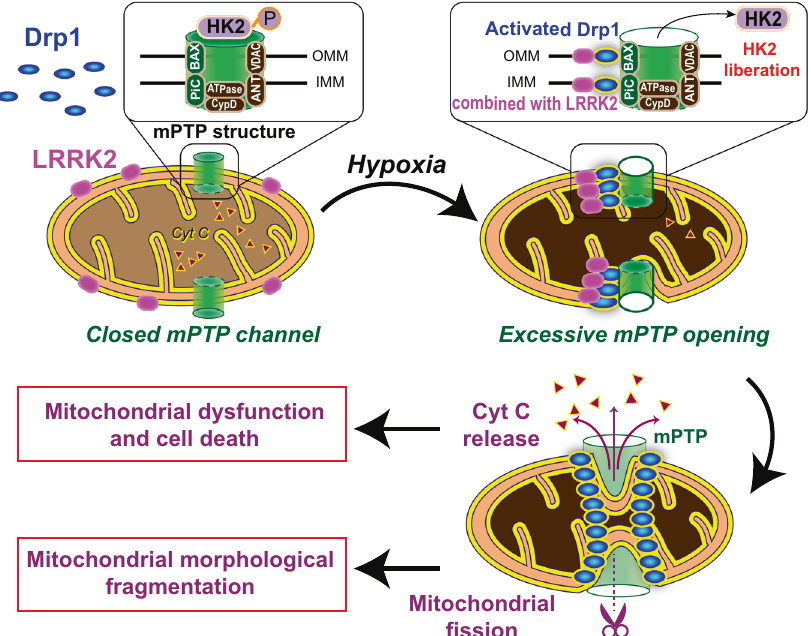
Fig. 5 The schematic diagram showing the mechanisms of mitochondrial Drp1 recognizing and inducing excessive mPTP opening after hypoxia. Hypoxia-activated mitochondrial Drp1 fi rstly recognizes mPTP channels through binding with its structural proteins, BAX and PiC, then recruits LRRK2 to mitochondrial contraction or fi ssion sites and blocks its kinase activity site (LRRK2 G2019), leading to the dephosphorylation and mitochondrial separation of mPTP related protein HK2, resulting in structural damage and excessive opening of mPTP channel after